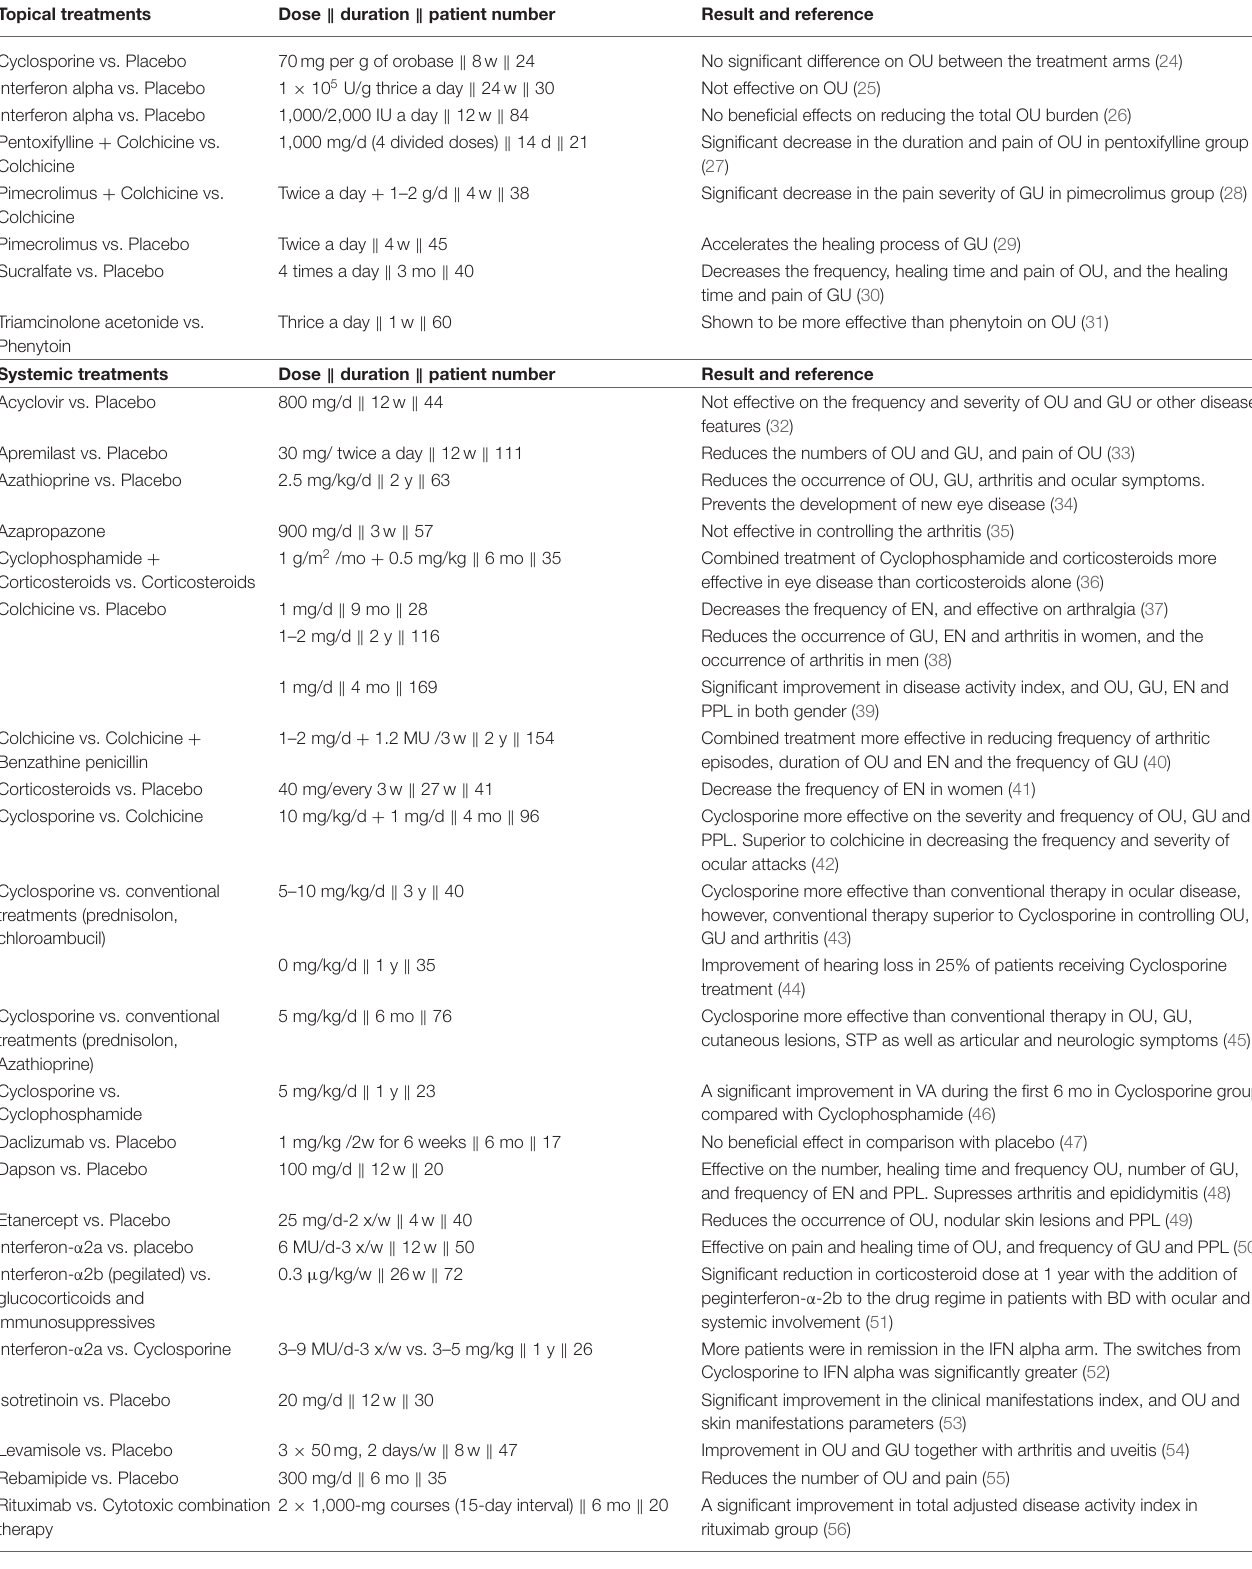
TABLE 1 | The main topical and systemic therapeutic agents used in the treatment of Behçet’s disease in randomized, controlled